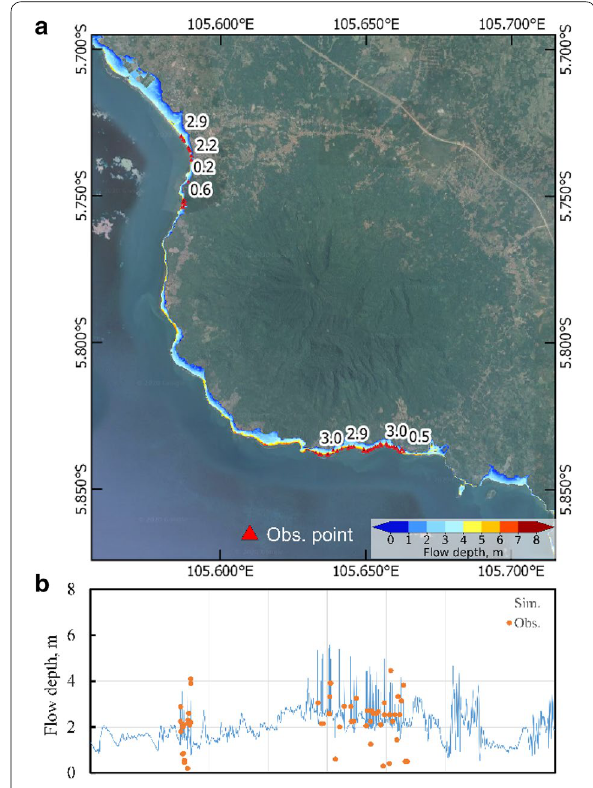
Fig. 14 Impact of the tsunami along the coastline in area C: a flood extent and locations of survey points; b water level along the coastline and comparison with observation data